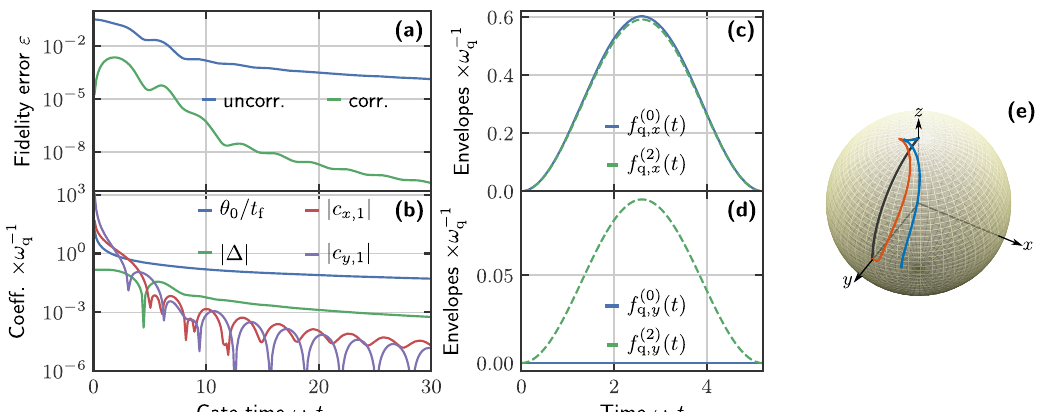
Fig. 2 Modi fi ed dynamics of a qubit in the strong-driving limit. a Average fi delity error for a Hadamard gate as a function of gate time. The blue trace is calculated using the uncorrected Hamiltonian (see Eq. (37)). The green trace is obtained for the modi fi ed Hamiltonian (up to second order). b Coef fi cient of the of original pulse f q ( t ) and the coef fi cients of the correction Hamiltonian as a function of the gate time. Here, c α ; 1 ¼ c ð 1 Þ α ; c ð 2 Þ α ; and Δ = Δ (1) + Δ (2) . c , d Original pulse and corrected pulse for ω d t f ≈ 5. In ( c ), we plot f ð n Þ 1 þ 2 (58). e Trajectory on the Bloch sphere of the ideal dynamics (gray), of the uncorrected dynamics (blue), and of the corrected dynamics